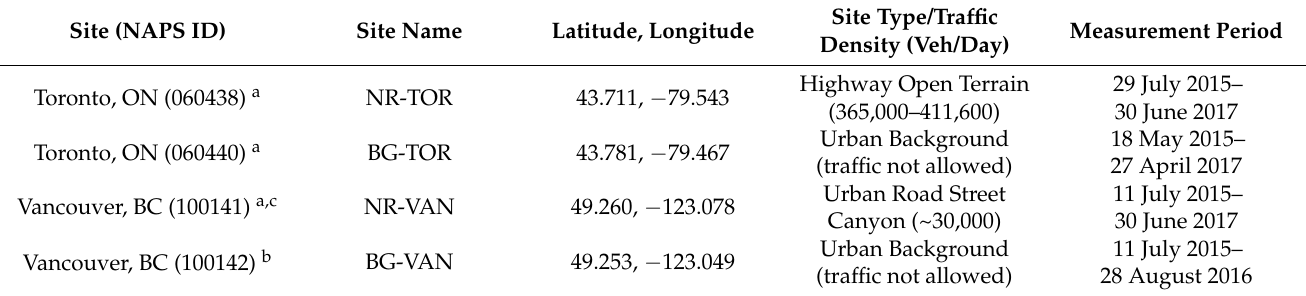
Table 1. Description of the sampling locations and measurement